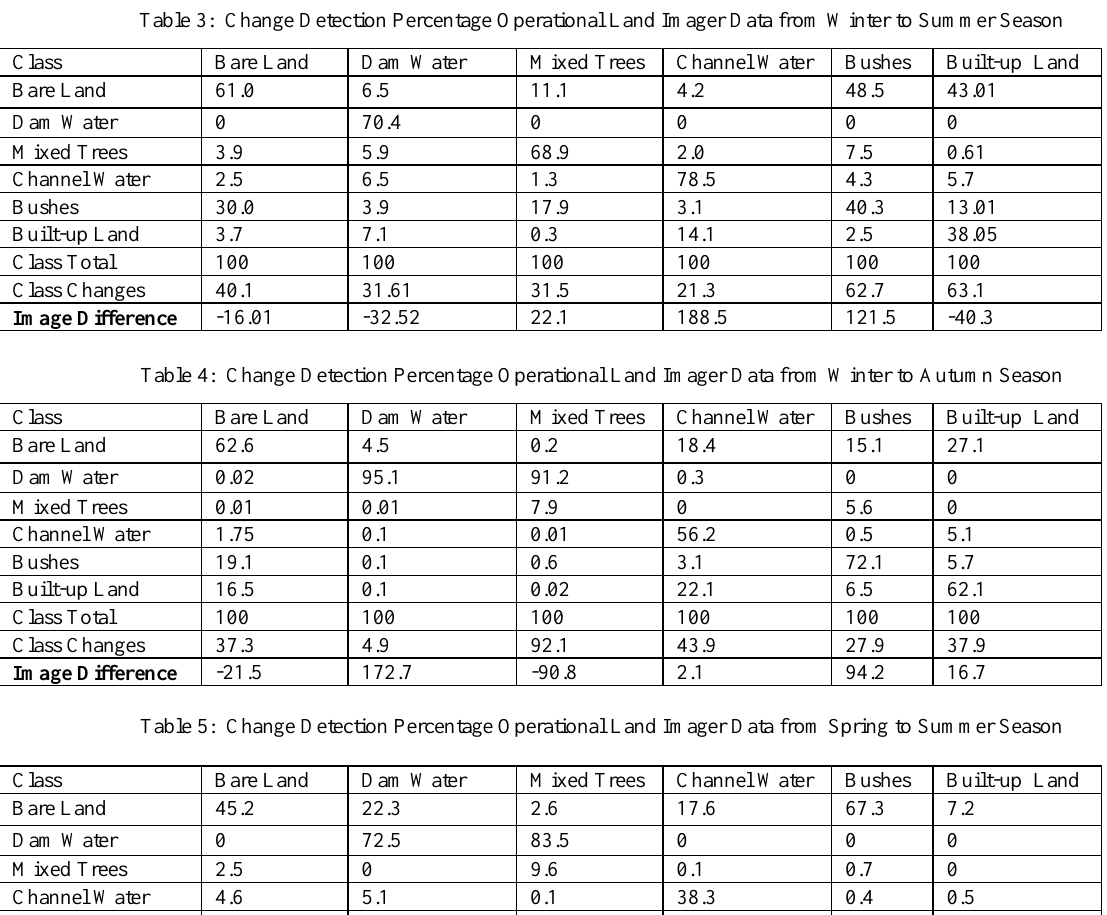
Table 3: Change Detection Percentage Operational Land Imager Data from Winter to Summer Season Class Bare Land Dam Water Mixed Trees Bare Land Dam Water Mixed Trees